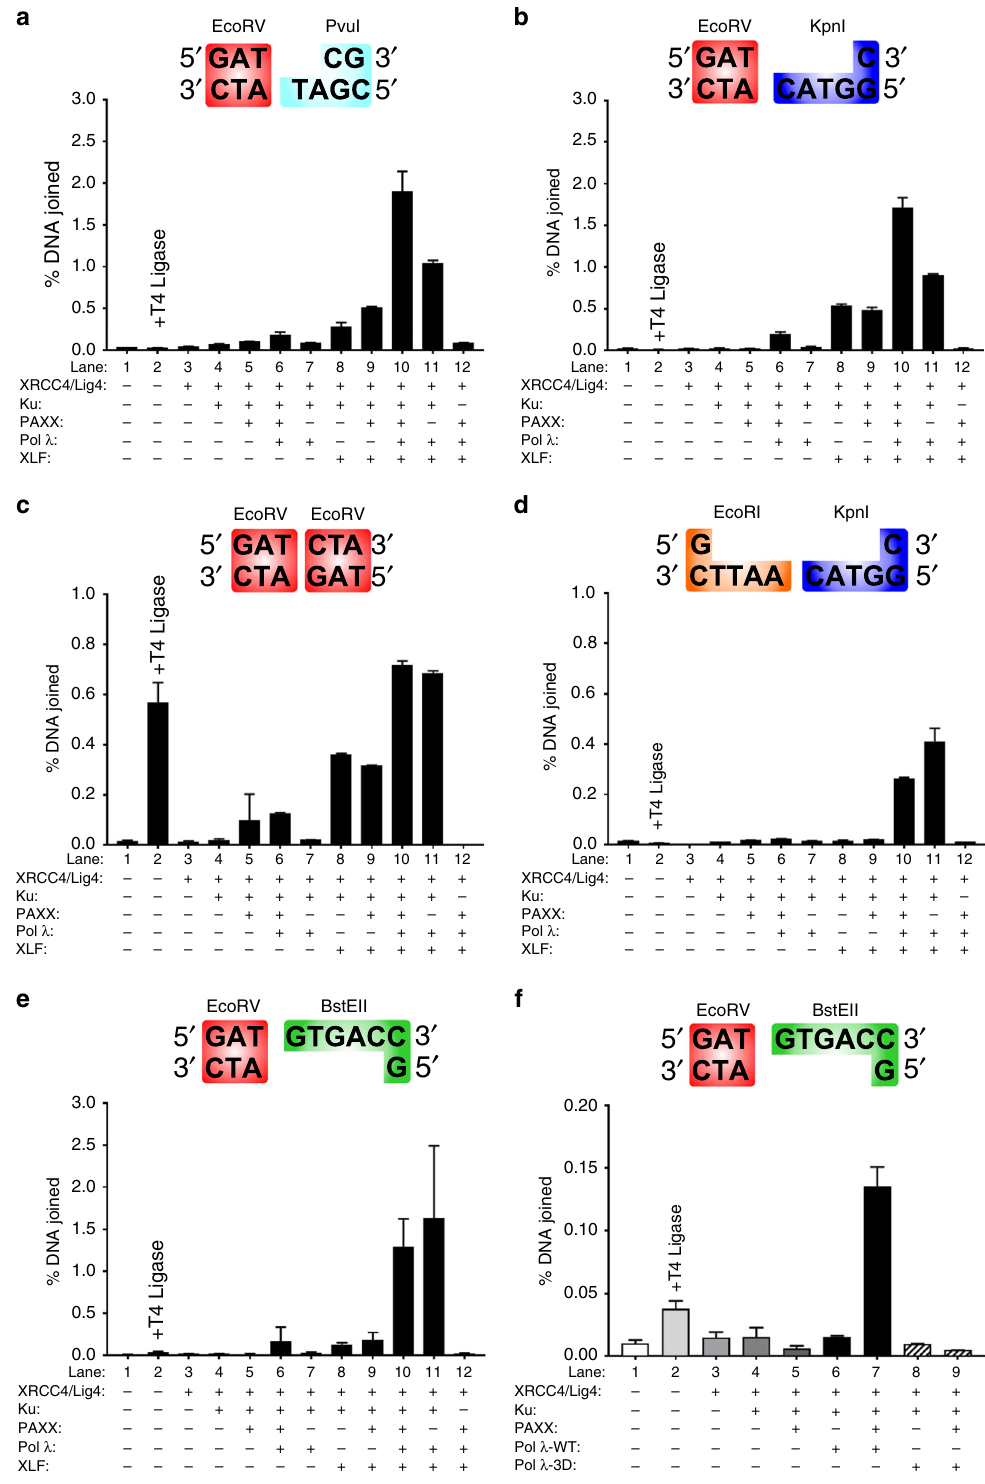
Fig. 9 PAXX and XLF together with Pol λ to promote ligation of noncohesive DNA ends which requires gap fi lling activity of Pol λ . a – e Linear DNA substrates as shown were incubated with the indicated combinations of XRCC4/Lig IV, Ku70/80, PAXX, XLF and Pol λ and the joining ef fi ciency quanti fi ed by qPCR with a TaqMan probe using a standard curve of log 10 % joining ef fi ciency versus C t value generated using prejoined DNA fragments. DNA substrates were as follows: ( a ) EcoRV-PvuI blunt-2nt 3 ’ overhang; ( b ) EcoRV-KpnI blunt-4nt 3 ′ overhang; ( c ) EcoRV-EcoRV blunt-blunt ends; ( d ) EcoRI- KpnI 4nt 5 ’ overhang-4nt 3 ′ overhang, ( e ) EcoRV-BstEII blunt-5nt 5 ′ overhang; ( f ) As described in Panel ( e ), except that ligation assays contained either Pol λ -WT or a catalytically inactive Pol λ -3D mutant. Results shown are the mean ± SEM from 2 – 3 experiments performed in